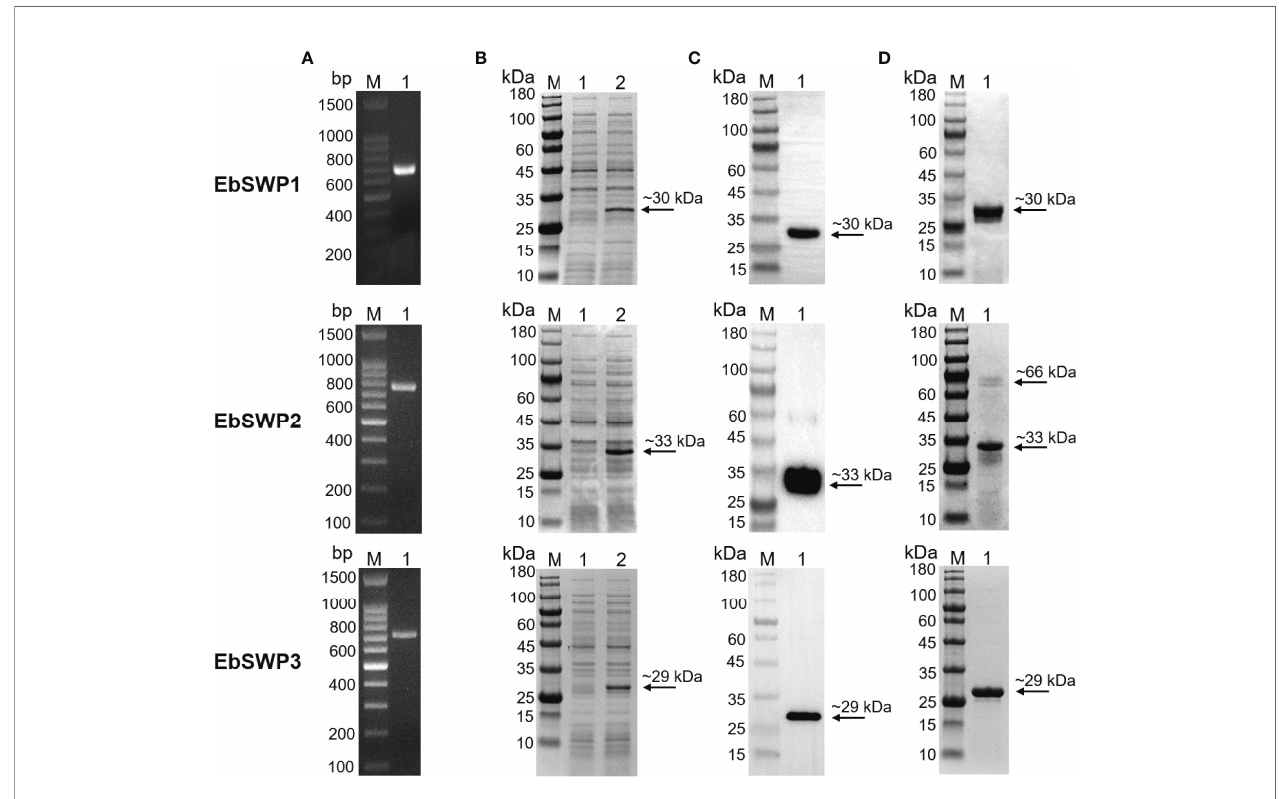
FIGURE 2 | Cloning, expression, and puri fi cation of recombinant spore wall proteins EbSWP1, EbSWP2 and EbSWP3 from Enterocytozoon bieneusi . (A) PCR ampli fi cation of the target genes in genomic DNA. Lane M: molecular markers; lane 1: PCR product. (B) Expression of recombinant EbSWPs in E. coli BL21 (DE3). Lane M: protein molecular weight marker; lane 1: bacterial lysate before induction; lane 2: bacterial lysate after induction. (C) Western blot analysis of recombinant EbSWPs with anti-His-Tag monoclonal antibody. Lane M: protein molecular weight marker; lane 1: puri fi ed recombinant proteins from Ni-NTA af fi nity chromatography. (D) Puri fi cation of recombinant EbSWPs with Ni-NAT af fi nity columns. Lane M: protein molecular weight marker; lane 1: puri fi ed EbSWPs observed by